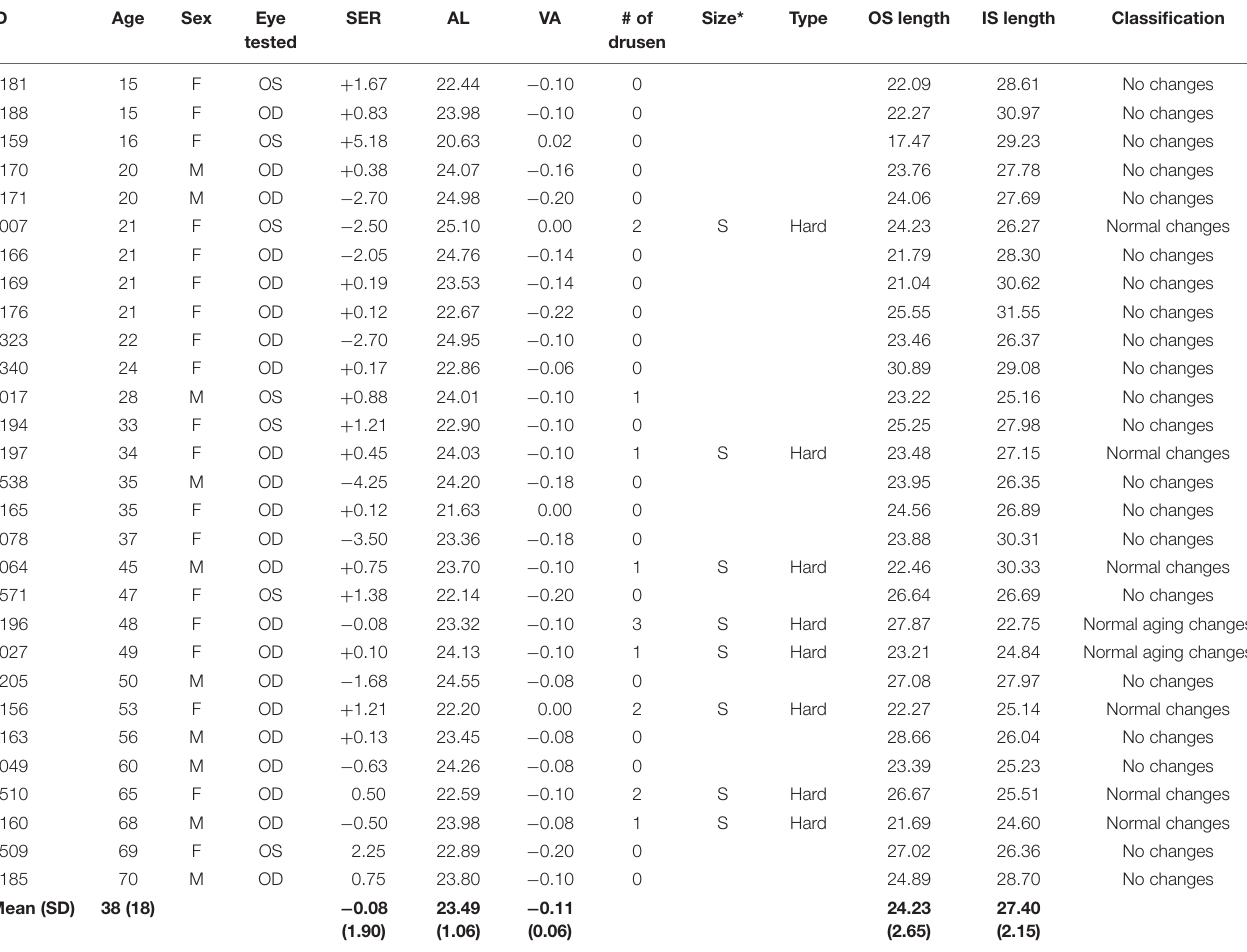
TABLE 2 | As Table 1 but for the 29 normal